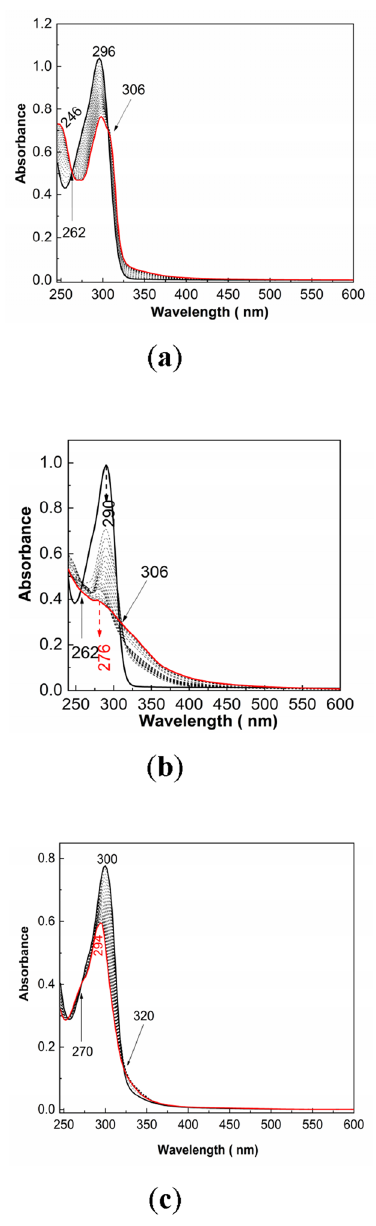
Figure 11. UV–VIS spectra of the PS ( 1 ; a, 0.02 mg/ml) and Controloc ( 4 ; b, the PS concentration is 0.02 mg/ ml) and their evolution when the two samples are exposed 80 min. to UV light. Figure ( c ) shows UV–VIS spectra of the PS ( 1 ) interacted with NaOH 0.3 M. Black and red solid lines correspond to the UV–VIS spectra of the PS ( 1 ) and Controloc ( 4 ) solutions prior and after exposure to UV light, respectively, time of 80 min. Black dash lines correspond to the UV–VIS spectra of the PS ( 1 ) and Controloc ( 4 ) solutions subsequently exposed for 2 min. to UV